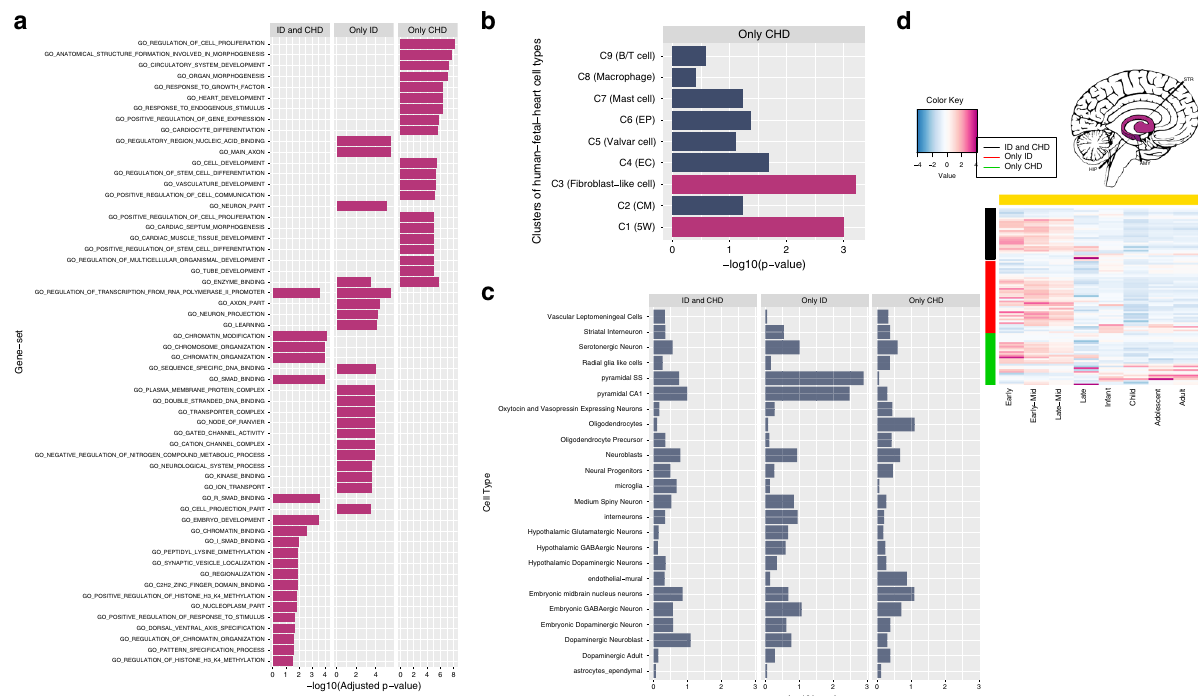
Fig. 6 The analysis results of shared and speci fi c gene lists for ID and CHD (Only CHD: CHD-speci fi c genes, Only ID: ID-speci fi c genes, ID and CHD: shared genes). a Top enrichment results of gene-ontology (G0) gene sets. These are the top 20 enriched gene sets of each gene list. All these results have adjusted- p -value < 0.05. b Enrichment results of human single-cell RNA sequencing (scRNAseq) datasets. These cells are from cardiac cells of the human fetal heart. They were clustered into 9 clusters (e.g., C1 to C9). The information of these clusters is in brackets (5W: 5-week hearts, ECs: endothelial cells, CMs: cardiomyocytes, epicardial cells: Eps). Magma-red bars are for results with adjusted p -value < 0.05 c ) Enrichment results of mouse scRNAseq expression data. d BrainSpan expression results for the three gene lists. This is for Region 3 as de fi ned by Huckins, et al. 34 including hippocampus (HIP), amygdala (AMY), striatum (STR) regions. The package cerebroViz 67 was used to draw brain